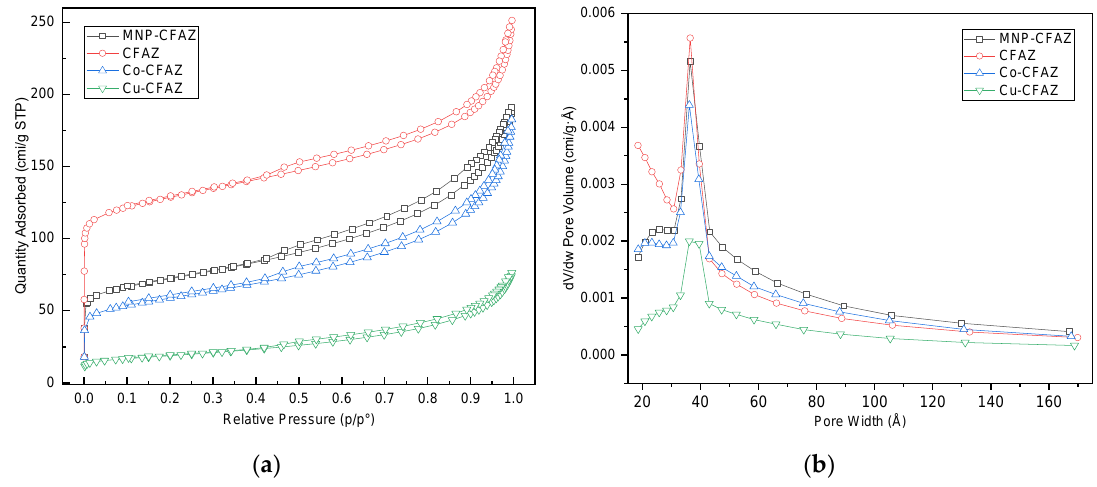
Figure 3. Results from N 2 adsorption/desorption analyses: ( a ) experimental N 2 -adsorption/desorption isotherms; ( b ) BJH-pore size distribution functions.